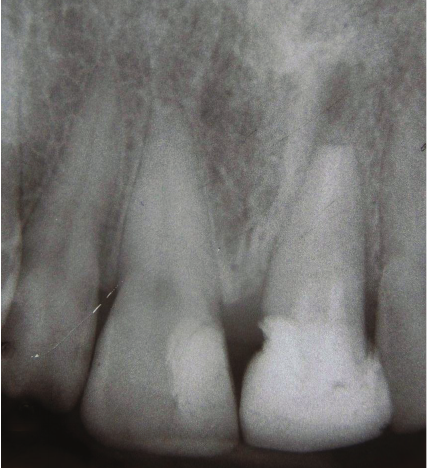
Figure 5: The prepared fracture line was sealed with dual-curing resin cement.